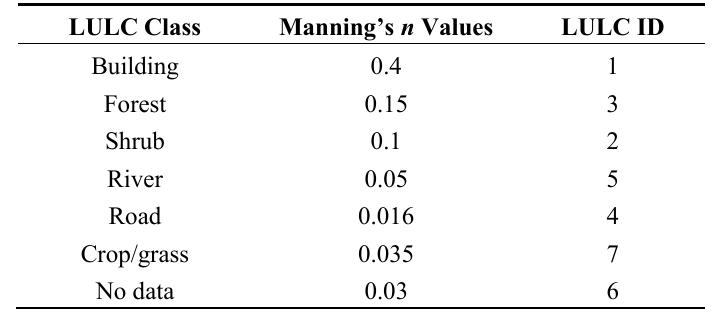
Table 3. Manning’s n values according to Chow [14]. The value of the building class is provided by Syme [48].